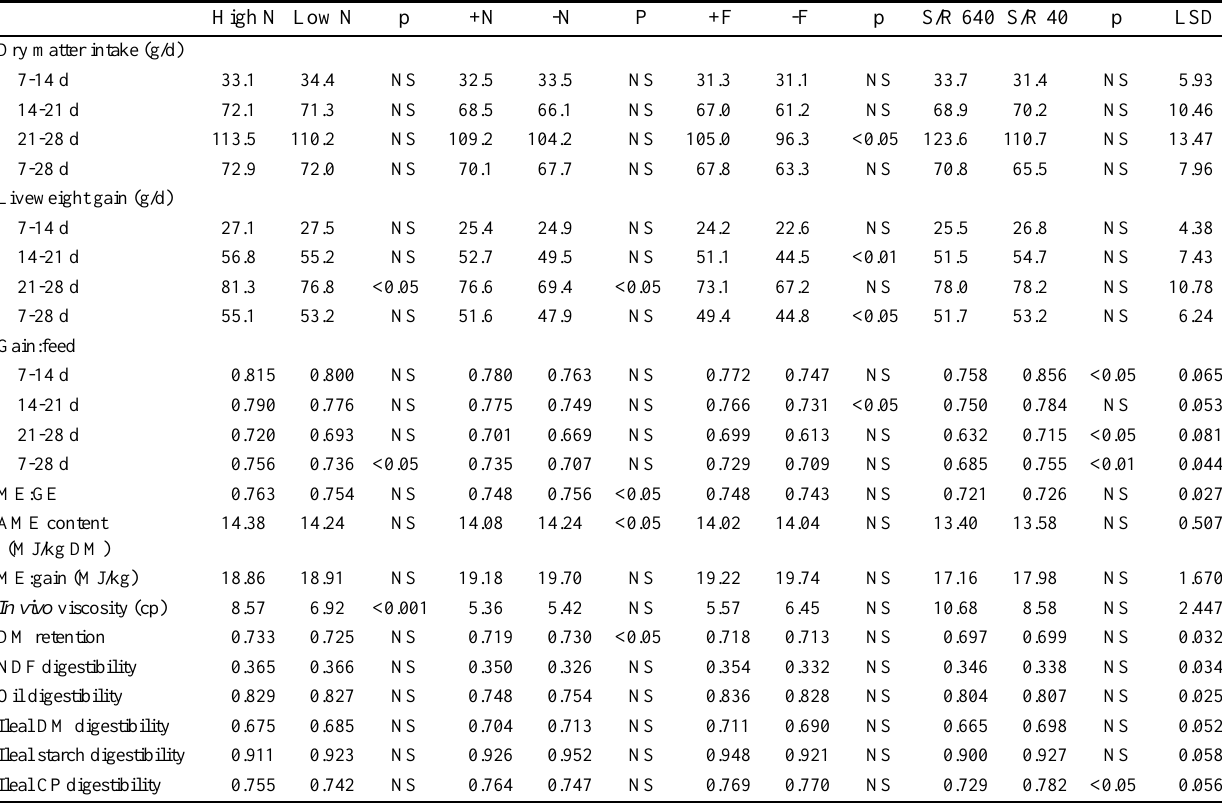
Table 4. The effect of N fertiliser and fungicide application and seed rate over all experiments High N Low